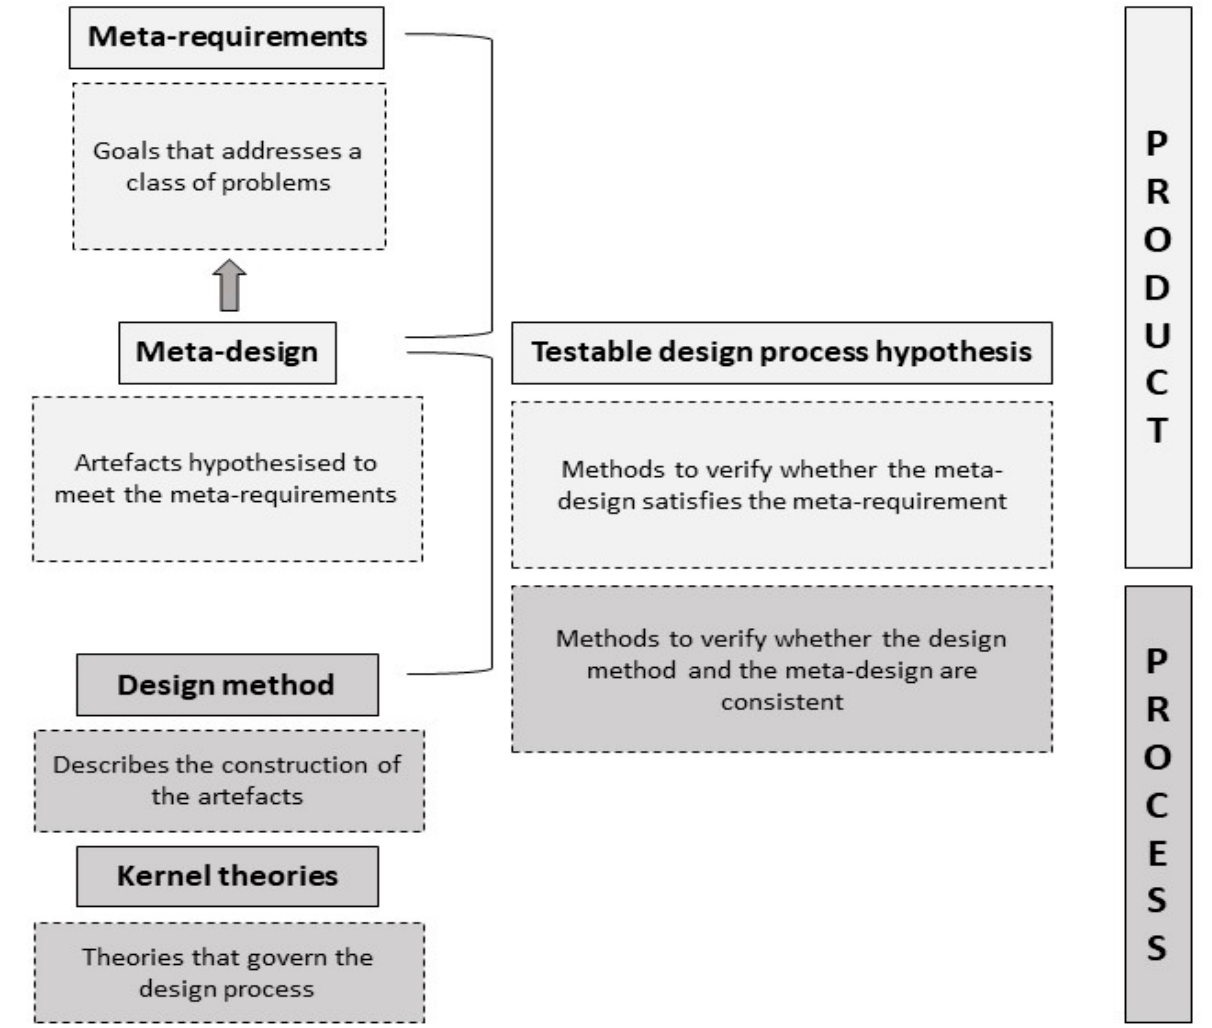
Figure 1. The framework of the design product and process of the design theory proposed by Walls et al. (1992 [28]).